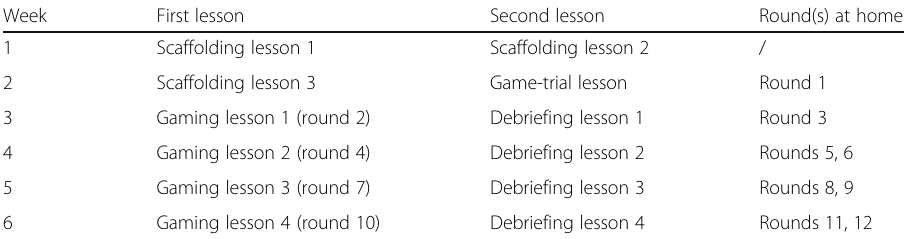
Table 1 Implementation schedule of VISOLE with the